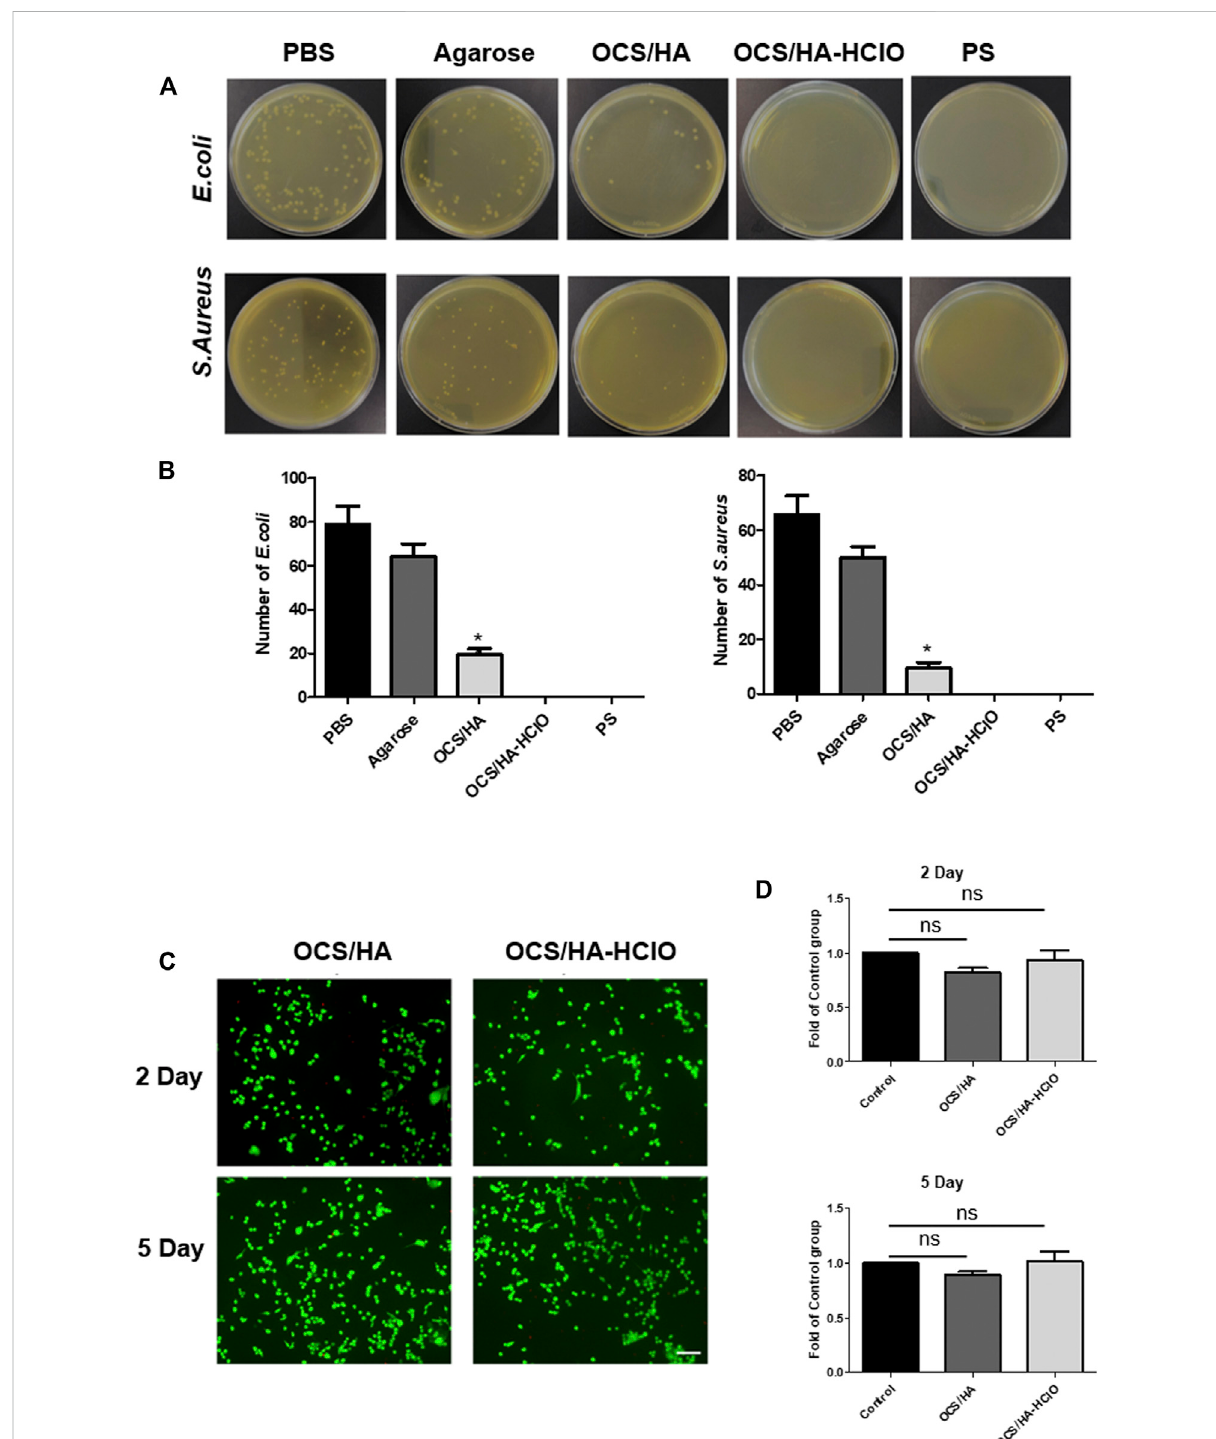
FIGURE 6 Antibacterial performance and biocompatibility of the OCS/HA and OCS/HA-HClO hydrogels. (A) Antibacterial performance of hydrogels against E.coli and S.aureus . (B) Quantitative data of A. In this experiment, the PBS group is the blank control; the Agarose group is the negative control; Penicillin-Streptomycin (PS) is the positive control. p < 0.05 (C) Live/dead staining of 3T3 cells on the surface of the OCS/HA and OCS/HA- HClO hydrogels after 2dand5 dof invitro culture, respectively( n =4, scalebar: 100 μ m). (D) Anti-proliferationeffect oftheOCS/HA andOCS/ HA-HClO hydrogels at 2 d and 5 d. ns: no signi fi cant, p >